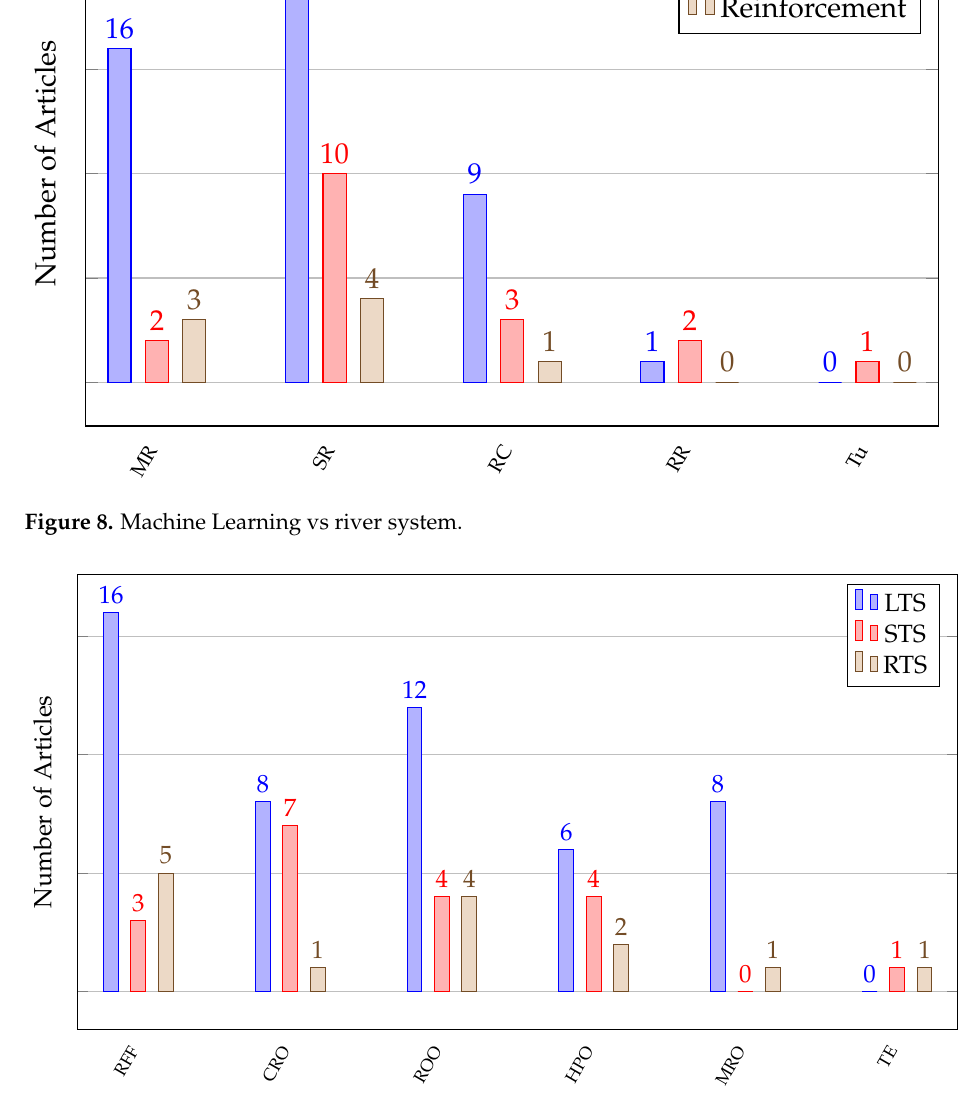
Figure 9. Main purpose forecast